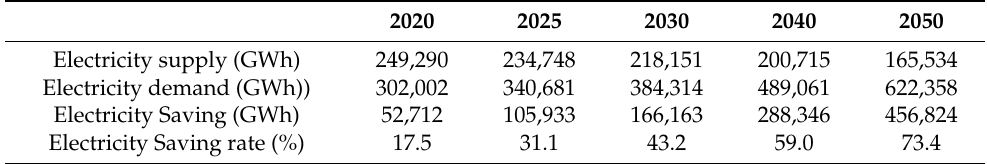
Table 8. The trajectory of electricity saving by